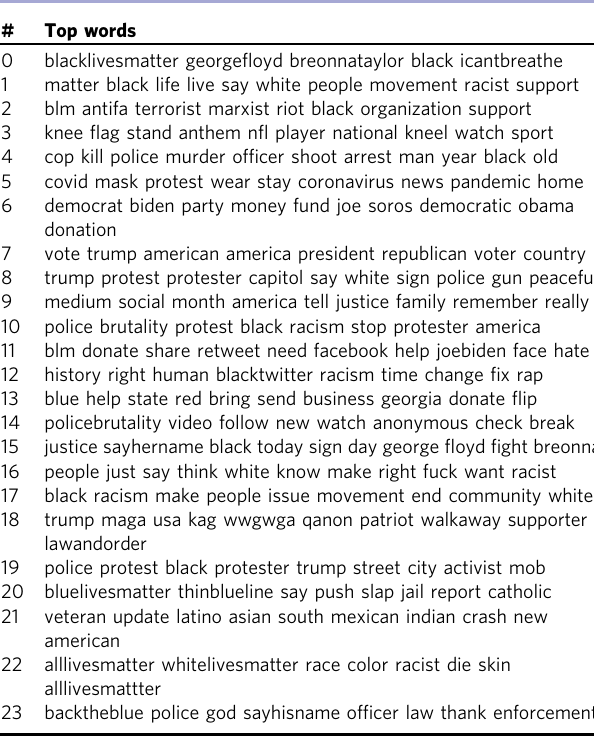
Table 2 Top words for each LDA topic. Model fi tted on aggregate author tweets.